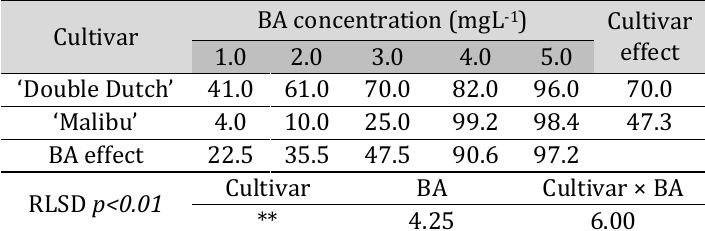
Table 1. Effect of cultivar and BA and the interaction between them on the callus induction rate from the young leaf of gerbera plant after 12 weeks of